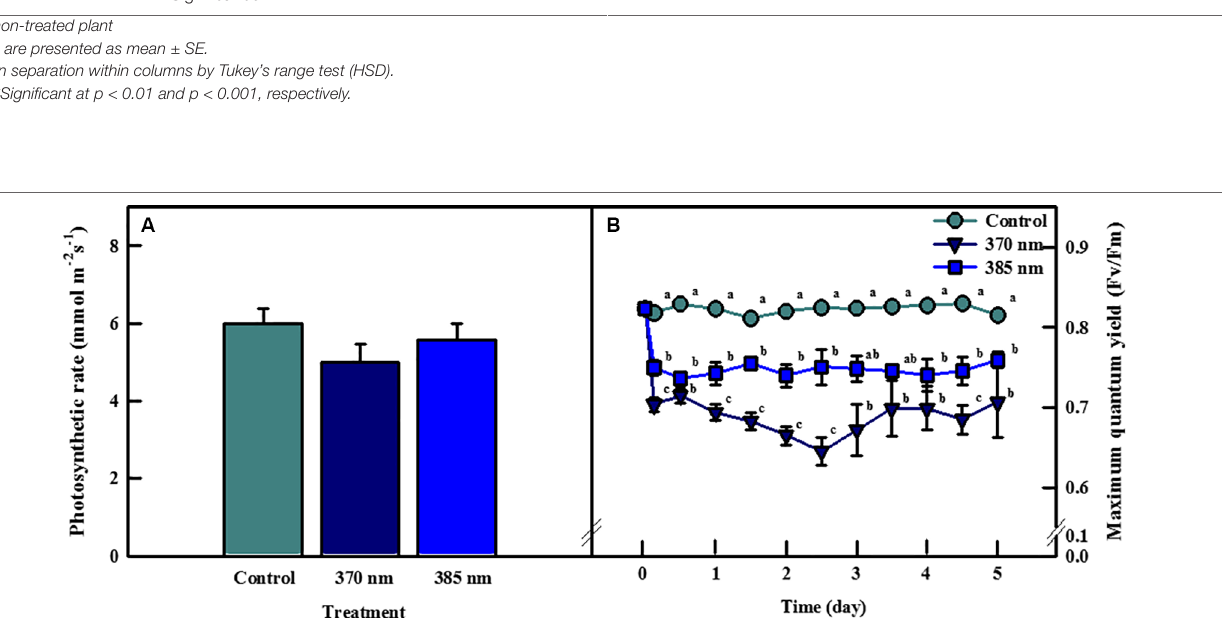
FIGURE 2 | Photosynthetic rate of kale subjected to two types of UV-LED lights (370 and 385 nm) at 4 days (A) and maximum quantum efficiency of photosystem II (Fv/Fm) of kale subjected to two types of UV-LED lights (370 and 385 nm) for 5 days (B) . The vertical bars indicate standard errors (n = 5). Different letters indicate significant differences, as assessed by ANOVA ( p <